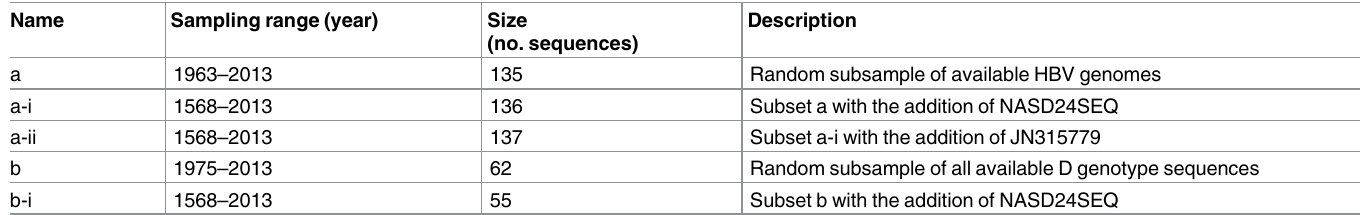
Table 3. HBV data sets. All individualdata sets were compiledfrom a larger overall data set of whole-genome HBV sequencesthat includeda collection date (1963–2014). See Methods for a more comprehensive description of individual data sets.